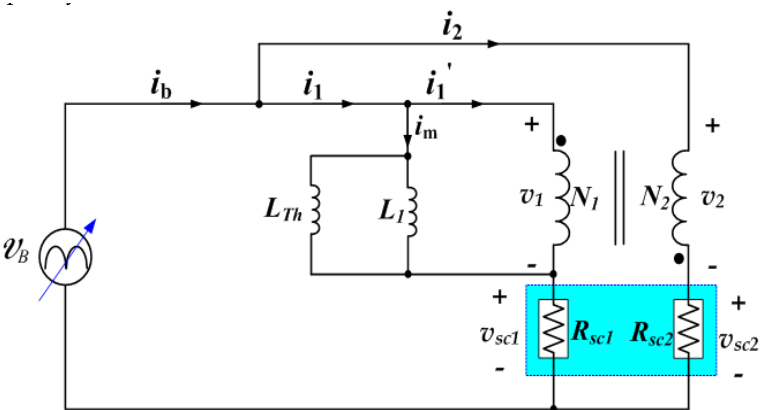
Figure 2. Electrical equivalent circuit of bridge type SFCL with simultaneous quench using flux-coupling according to the input voltage variation.